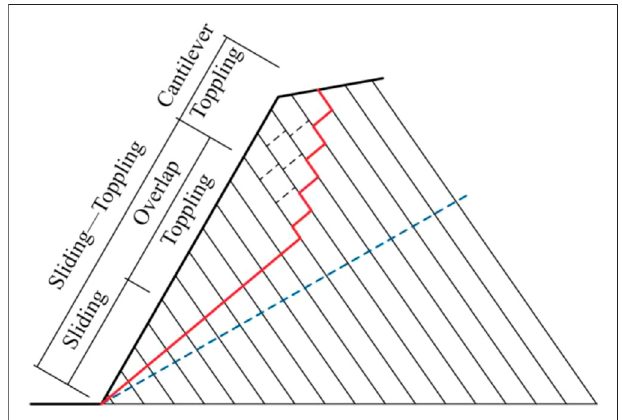
FIGURE2| Failuremodezoningof fl exuraltoppling(modi fi edfromChen et al. (2016).